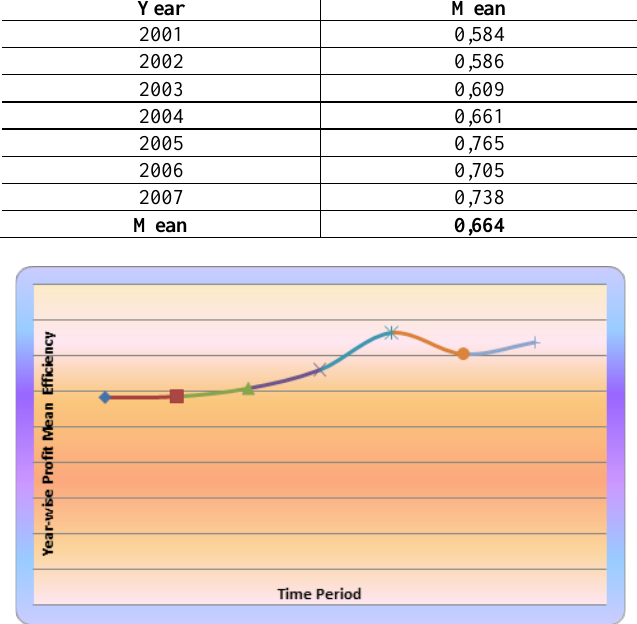
Figure 1: Year-wise average profit efficiency over time The year wise average profit efficiency of 20 banks in Bangladesh displayed in Table 7 and figure 2. From this investigation we observed that the highest average profits efficiency was in 2005 and the inefficiency score was 76,5 per cent and in 2001 the profit efficiency was 58,4 per cent.